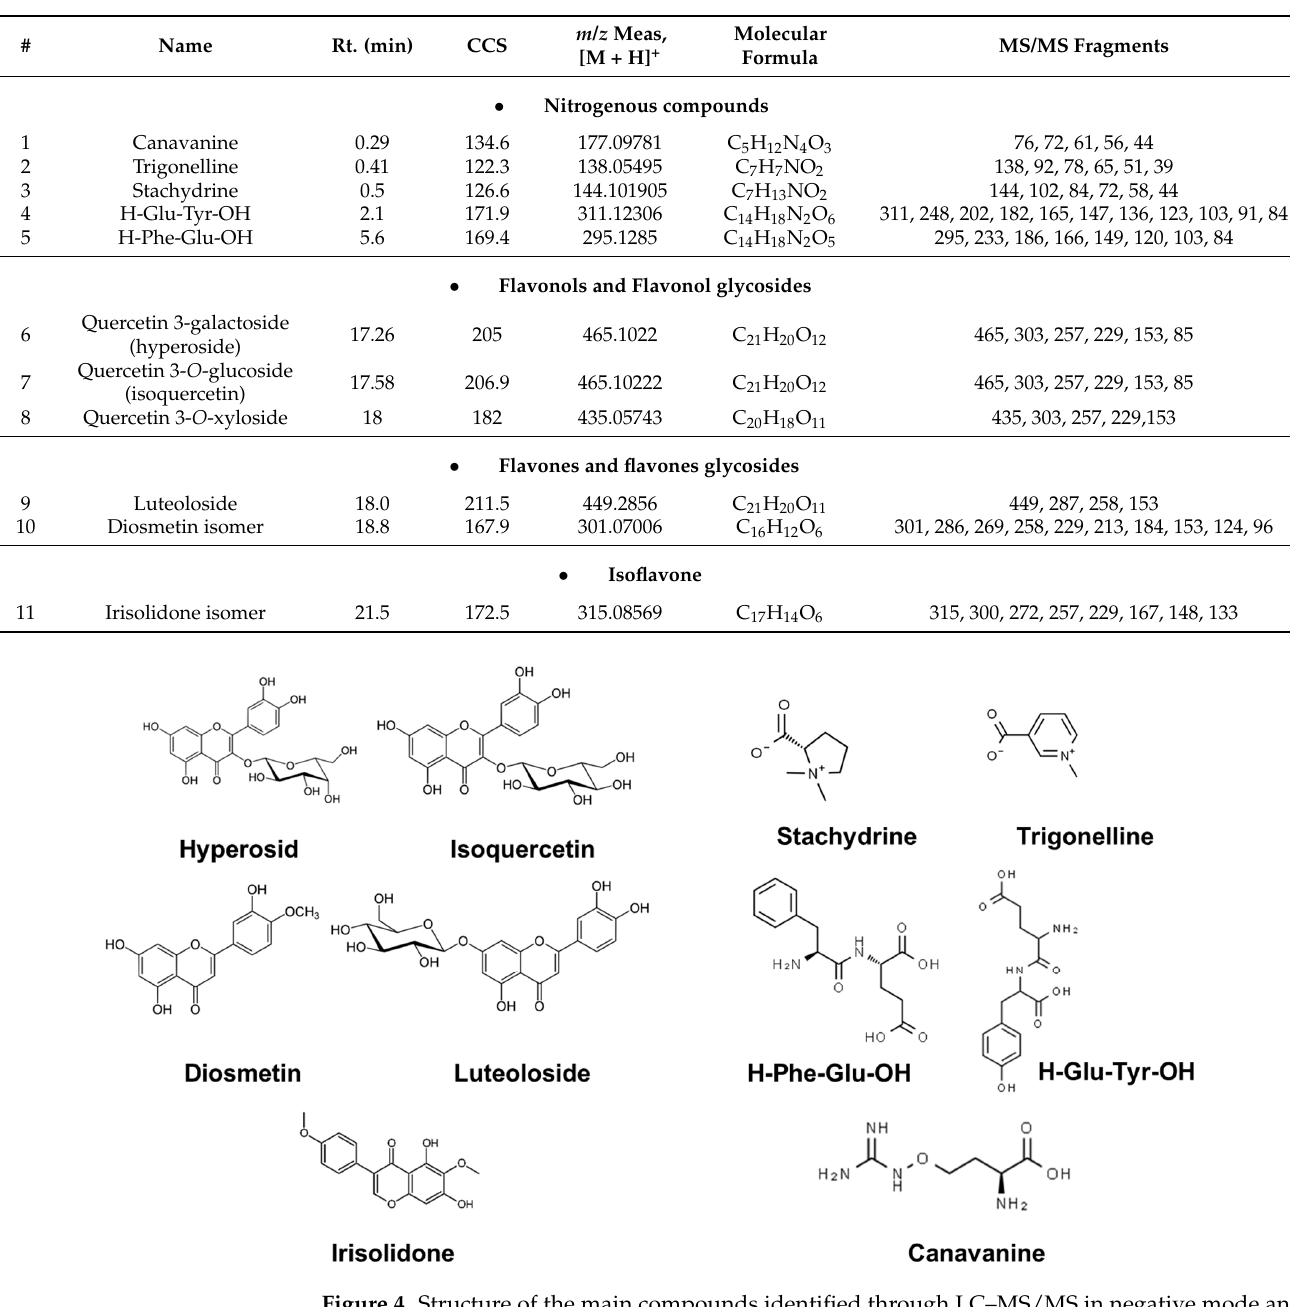
Table 1. Characterization by UPLC-ESI-QTOF-MS/MS of the compounds present in the alfalfa exudates.